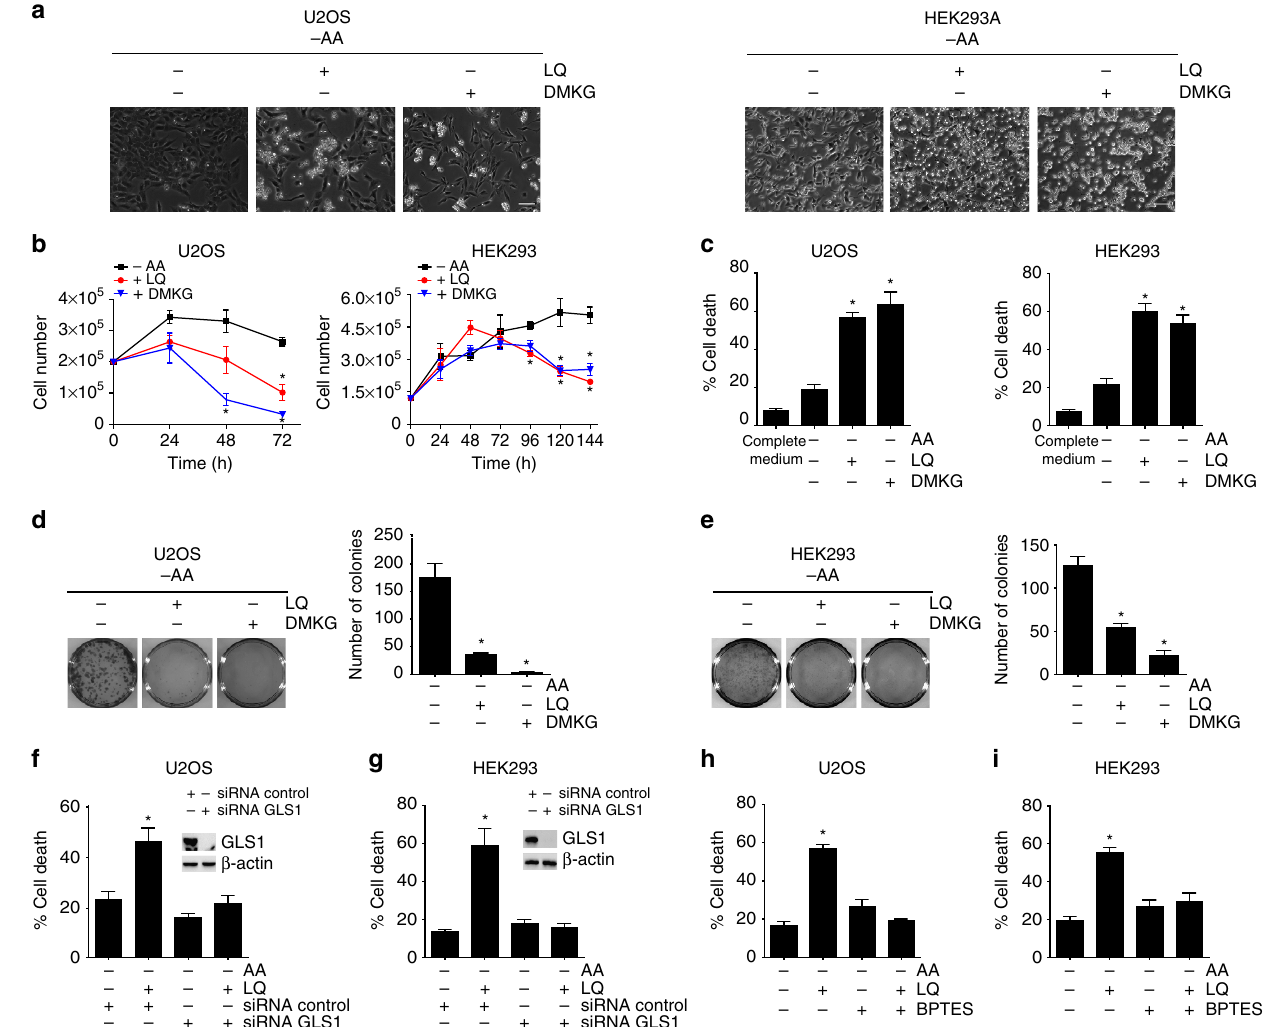
Figure 1 | Long-term glutaminolysis activation during amino acid restriction decreased cell viability. ( a ) U2OS (left panel) and HEK923 (right panel) cells were starved for all the amino acids ( (cid:2) AA) in the presence or absence of LQ or DMKG (2mM) for 72h (U2OS) or 144h (HEK293). Representative microscopy images of the cells are shown for the indicated conditions. The scale bar represents 100 m m. ( b ) Proliferation curves for U2OS and HEK293 were determined upon (cid:2) AA, in the presence or the absence of LQ and DMKG after 24–144h. ( c ) Percentage of cell death was estimated using trypan blue exclusion assay upon LQ or DMKG treatment after 72h for U2OS or 144h for HEK293, as indicated. ( d , e ) A representative image of a clonogenic assay (left panel) and the quantification of the colonies formed in three independent experiments (right panel) are shown for U2OS ( d ) and HEK293 ( e ). ( f , g ) Percentage of cell death was estimated in cells depleted of GLS1 (siRNA GLS1) upon amino acids starvation either in the presence or the absence of LQ after 72h for U2OS ( f ) and 144h for HEK293 ( g ). ( h , i ) Percentage of cell death was estimated upon amino acids starvation either in the presence or the absence of LQ and BPTES (30 m M) after 72h for U2OS and 144h for HEK293 cells. Graphs show mean values ± s.e.m. ( n ¼ 3). * P o 0.05 (Anova post hoc